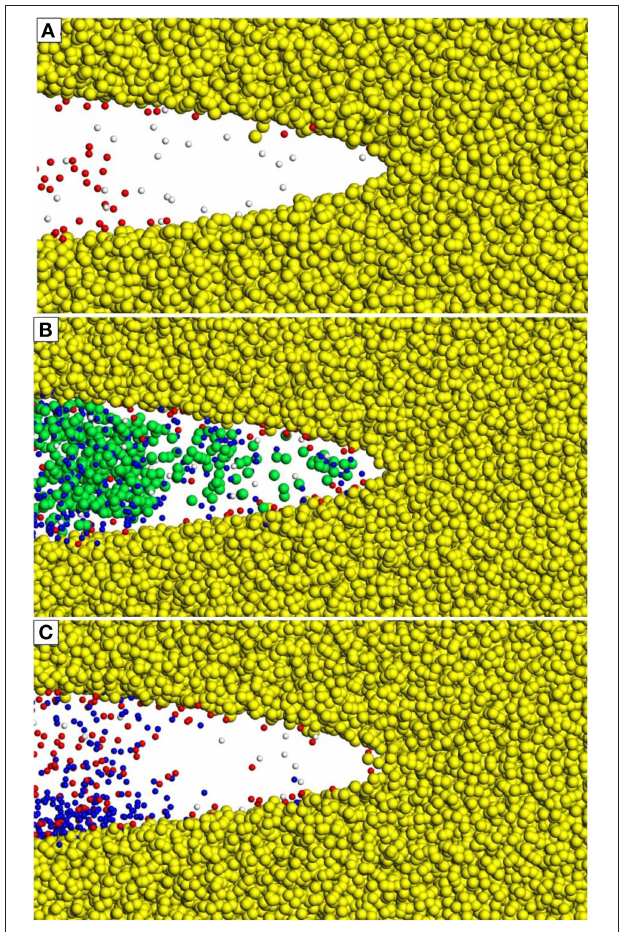
FIGURE 5 | Atomic positions of Na + , Cl − , OH − , and H 3 O + molecules inside the crack tip for three different solutions (A) water, (B) , 1M NaCl, and (C) 1M NaOH. Water is not shown for clarity. All 12 replicates are overlaid to sample the variety of atomic positions and are at a constant loading of 0.2 MPa √ m. Atom types: Si (yellow), Na + (blue), Cl − (green), OH − (red), H 3 O +